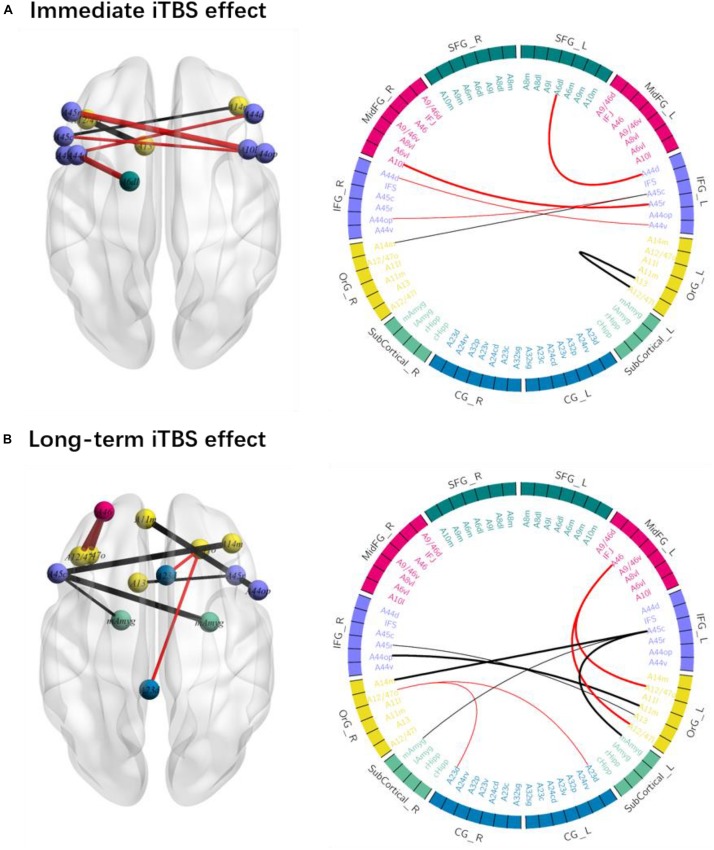
The immediate and long-term iTBS after-effects on the ROI-to-ROI functional connectivity (FC). (A) FC within the left frontal regions and between the bilateral areas changed at timepoint 2 as compared to that at timepoint 1. (B) FC within the bilateral frontal areas and between the left IFG and amygdala changed at timepoint 3 as compared to that at timepoint 1. FC increases are in red and FC decreases are in black (thick line: p < 0.05; thin line: p < 0.1).